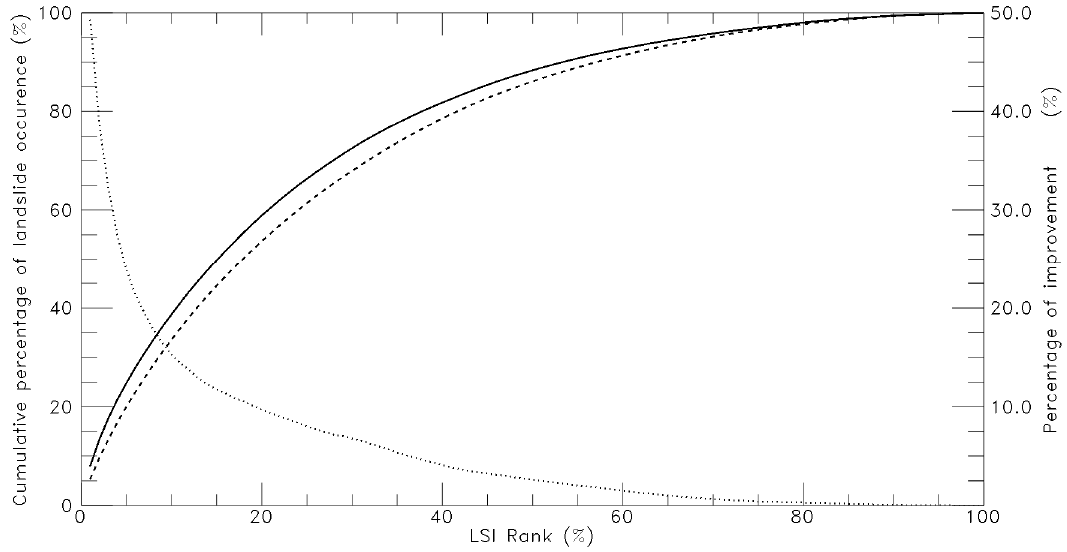
Figure 7. Cumulative percentage of landslide occurrence (CPOLO) based on LSM* (solid line) and LSM (broken line). The percentage of improvement ρ is plotted as a dotted line.